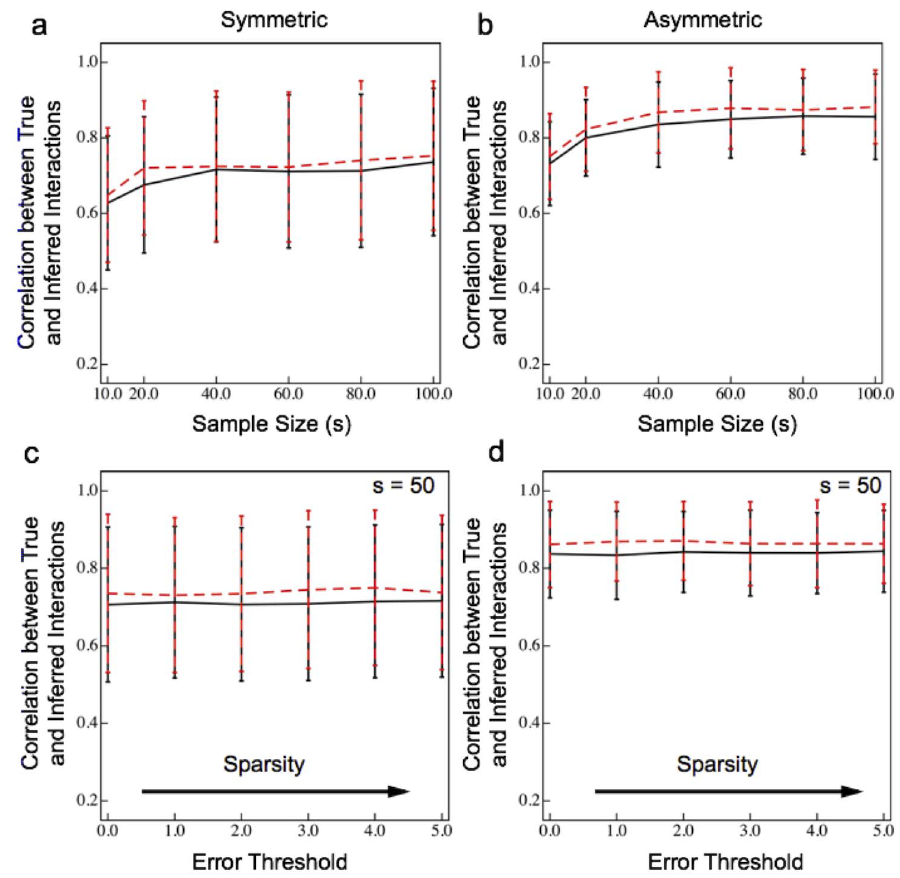
Figure 4. Performance of sparse linear regression as a functon of sample size and the prediction error threshold. a) Performance on absolute (red) and relative (black) abundances as a function of sample size for symmetric interaction matrices. b) Performance on absolute (red) and relative (black) abundances as a function of sample size for asymmetric interaction matrices. c) Performance on absolute (red) and relative (black) abundances as a function of the out-of-bag error threshold for symmetric interaction matrices. d) Performance on absolute (red) and relative (black) abundances as a function of the out-of-bag error threshold for symmetric interaction matrices. Error bars correspond to + one standard deviation, and lines connect the means.